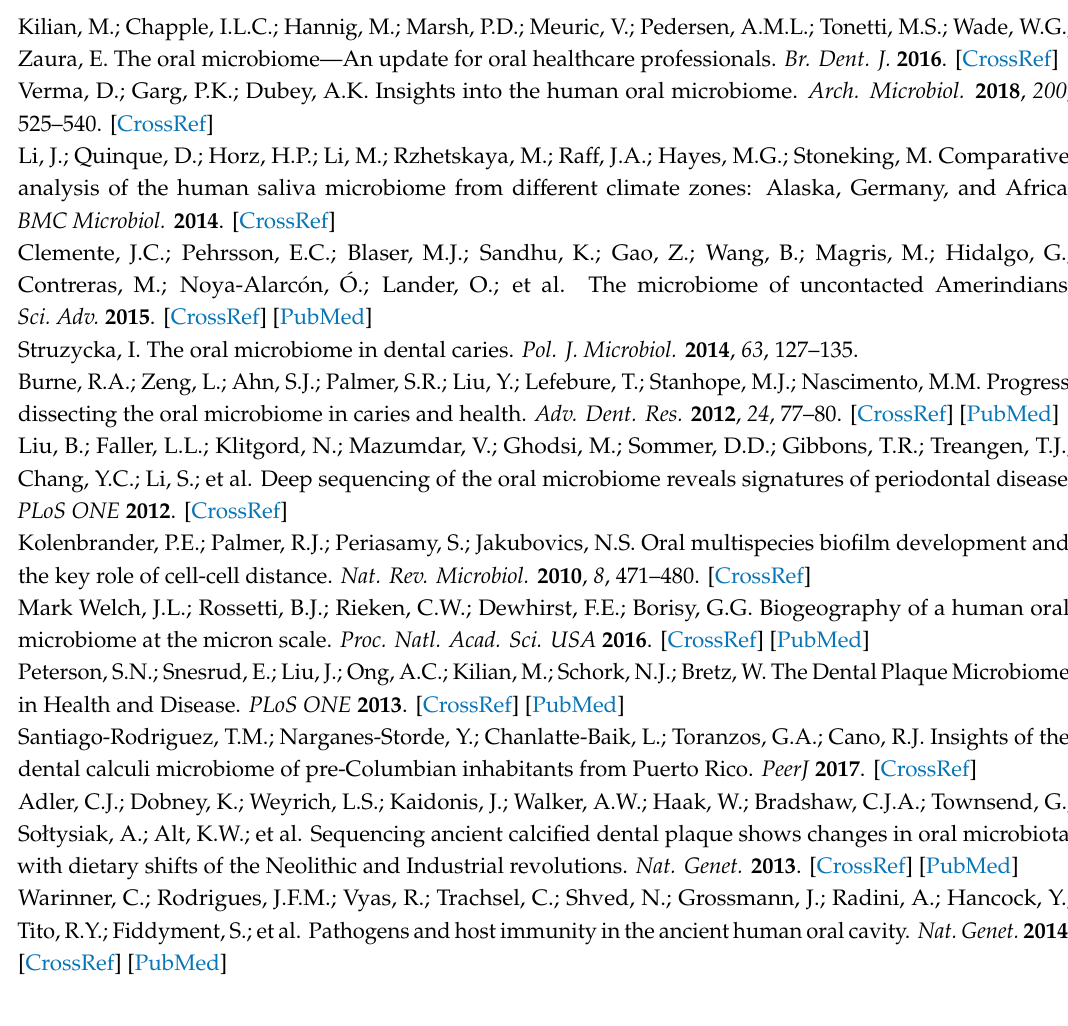
Figure S1: Microbiome analyses of dental calculus samples compared to extraction blank control and soil samples. Panel A shows a PCoA of the beta-diversity (Bray-Curtis) of the dental calculus samples prior filtering the Operational Taxonomic Units (OTUs) identified in the blank control. Panel B shows a PCoA of the beta-diversity (Bray-Curtis) of the dental calculus samples prior and after filtering the OTUs identified in the extraction blank and soil samples. Panel C shows the percentage of OTUs at the phylum level for the dental calculus samples prior and after filtering the OTUs identified in the extraction blank and soil samples, as well as those identified in the mentioned controls; Table S1: Number of sequences per sample prior- and post-filtering Operational Taxonomic Units (OTUs) identified in the soil samples from the archeological sites, as well as the extraction blank control.; Table S2: Additional information of the public sequence data included for comparisons with the dental calculus samples is shown. Information include 16S rRNA gene region sequenced, sequencing platform, sex, sample type, health status, collection country and